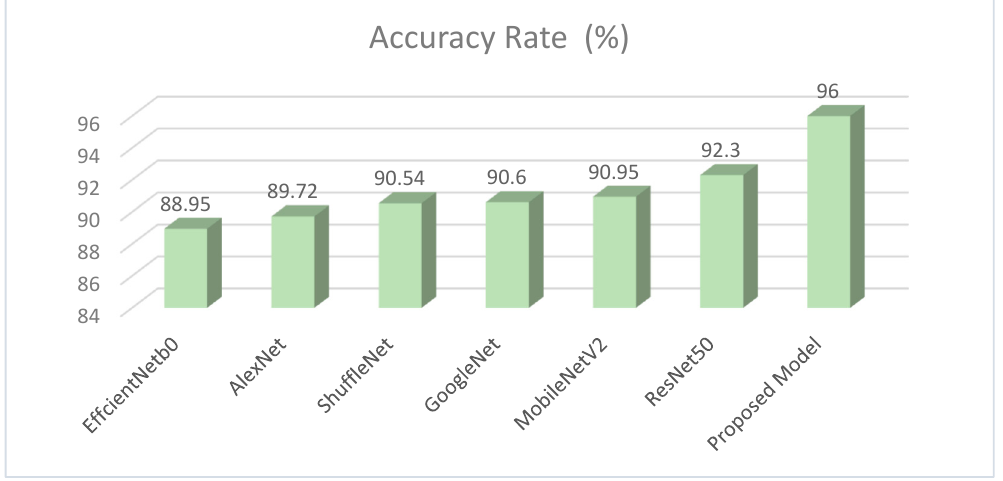
Figure 12. Accuracy rates of models.